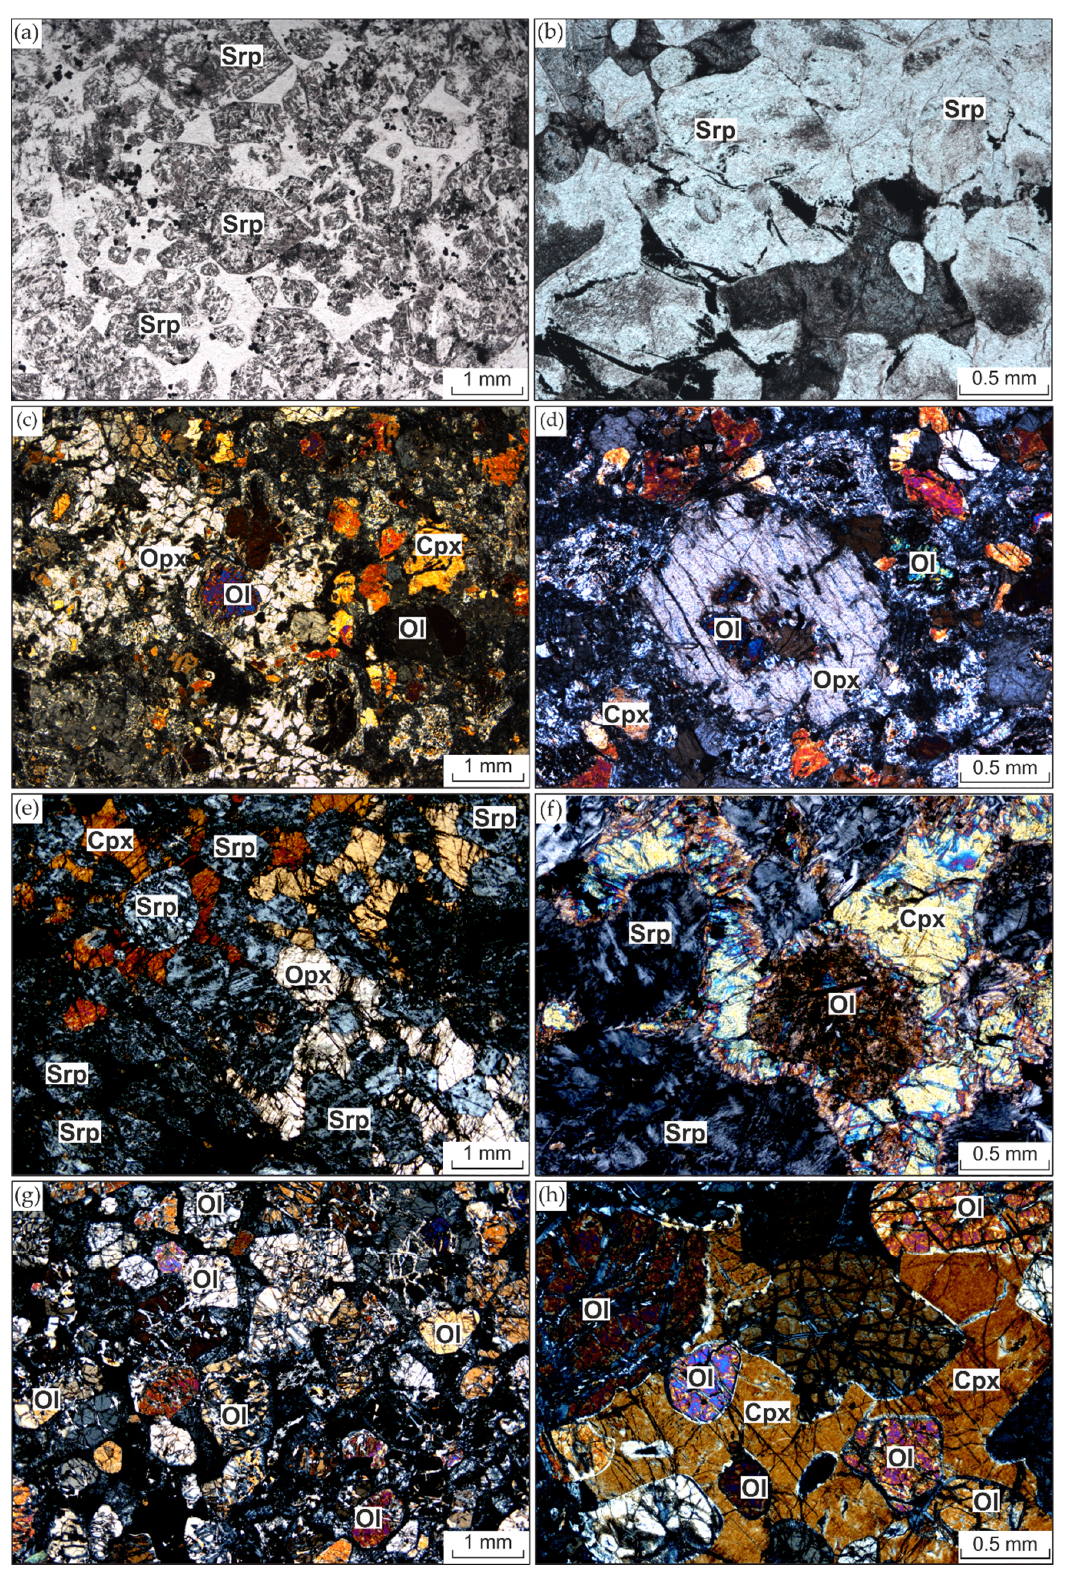
Figure 2. Photomicrographs showing textural characteristics: ( a,b ) The Moryany intrusion; ( c,d ) The Ulan-Khan intrusion; ( e,f ) The Zunduk intrusion; ( g,h ) The Onguren intrusion. (a,b) Plane-polarized light; (c–h) Cross-polarized light. Ol: olivine; Opx: orthopyroxene; Cpx: clinopyroxene; Srp: serpentine.